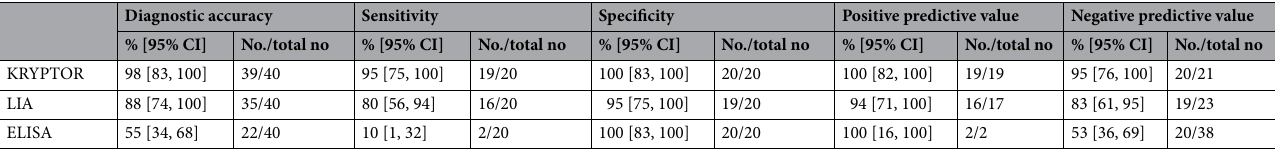
Table 4. Diagnostic performance of osmotically stimulated copeptin concentrations. A copeptin cut-off of 4.9 pmol/l was used for the differential diagnosis of central diabetes insipidus (≤ 4.9 pmol/l) and primary polydipsia (> 4.9 pmol/l). Copeptin was measured in duplicates using the KRYPTOR, the LIA and the ELISA. Diagnostic accuracy indicates correctly identifying patients as having central diabetes insipidus or primary polydipsia. Sensitivity indicates correctly identifying patients as having central diabetes insipidus. Specificity indicates correctly identifying patients as having primary